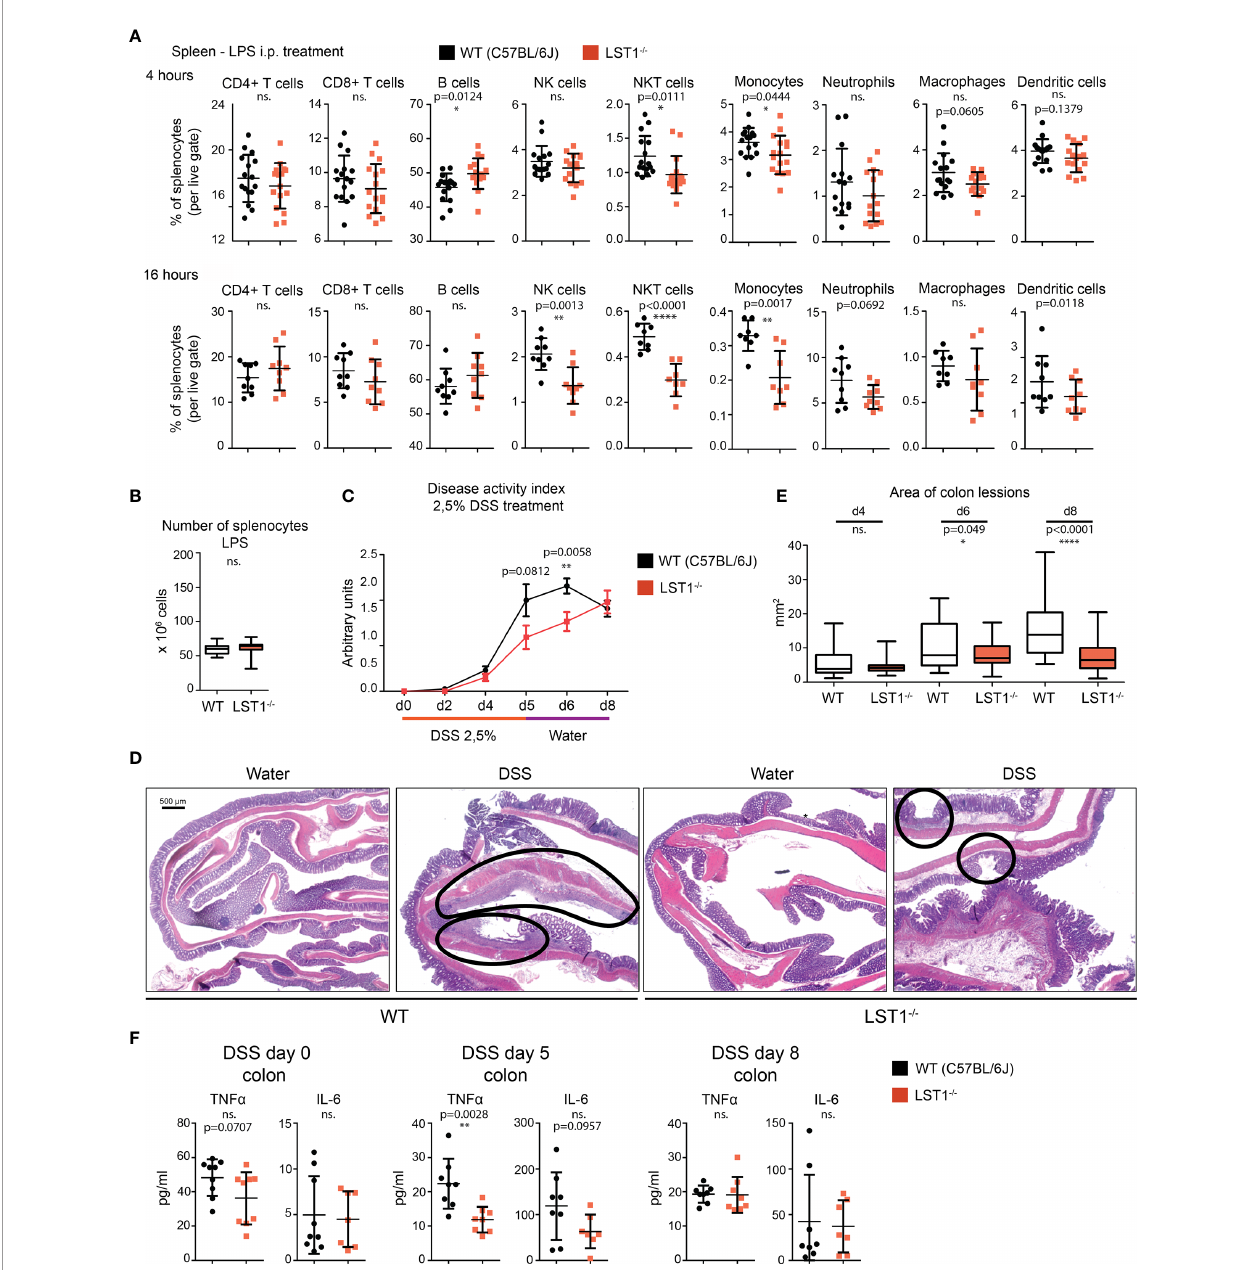
FIGURE 5 | In fl ammatory response in Lst1 -/- mice. (A) Percentages of major splenocytes subsets 4 and 16 hours after IP injection of LPS (n=8-9). Dots in scatter plots represent biological replicates. (B) Spleen cellularity 16 hours after LPS IP injection. (n=10) (C) DSS-induced colitis disease activity index (n=6-19 per time point) determined as described in Materials and Methods (higher numbers correspond to more severe symptoms) (D) Representative picture of colon sections stained with hematoxylin and eosin from control and DSS challenged WT and Lst1 -/- mice. Lesions are highlighted with black line (100x magni fi cation) (E) Quantitative evaluation of the size of colonic lesions induced by DSS treatment during multiple experiments (n=3-5 animals [26-56 lesions] per time point). (F) Concentrations of TNF a and IL-6 in colon homogenates from DSS-treated mice. Statistics evaluation was done by Student´s t-test (two-tailed, unpaired) and two-sided Grubb´s test. **p ≤ 0.01, ****p ≤ 0.0001, ns, not signi fi